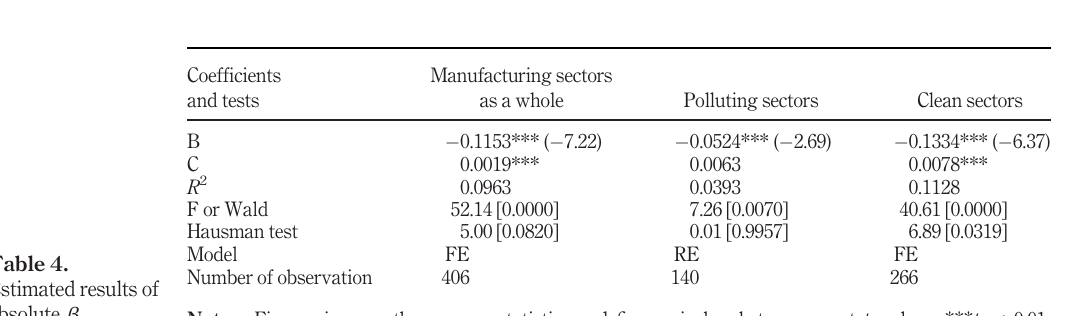
Figure 3. Trends of coef fi cient of variation for carbon productivity of manufacturing sectors